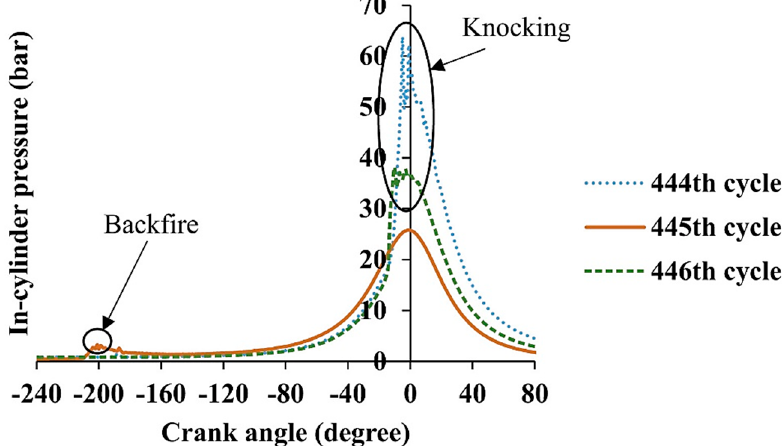
Figure 2. Occurrence of backfire and knocking (Dhyani et al. [59]).